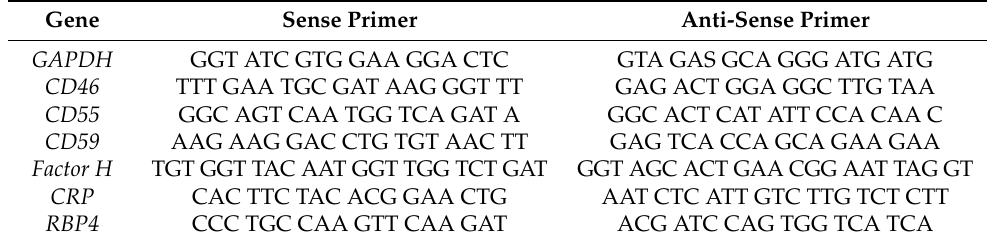
Table 1. List of primers used for